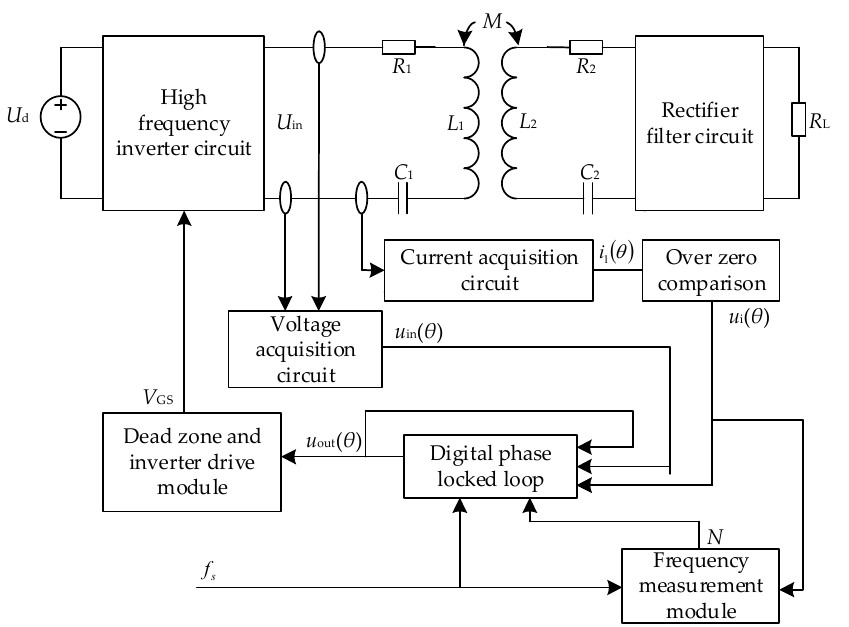
Figure 6. Block diagram of the frequency-tracking system control.